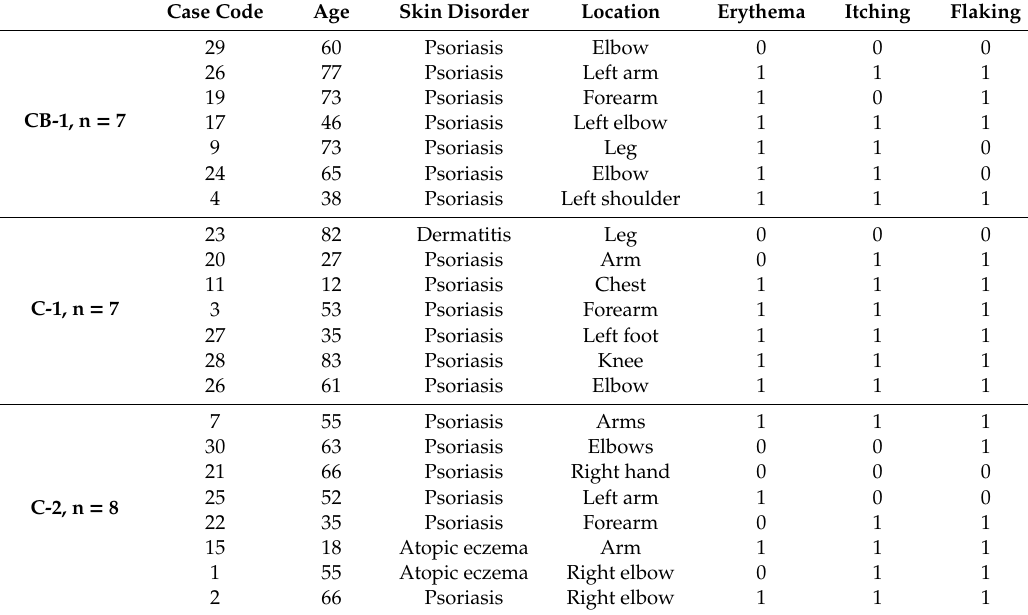
Table 4. E ff ects of each cream formulation (CB-1, C-1, C-2) in the symptoms of di ff erent skin disorders in 22 patients from Monfortinho